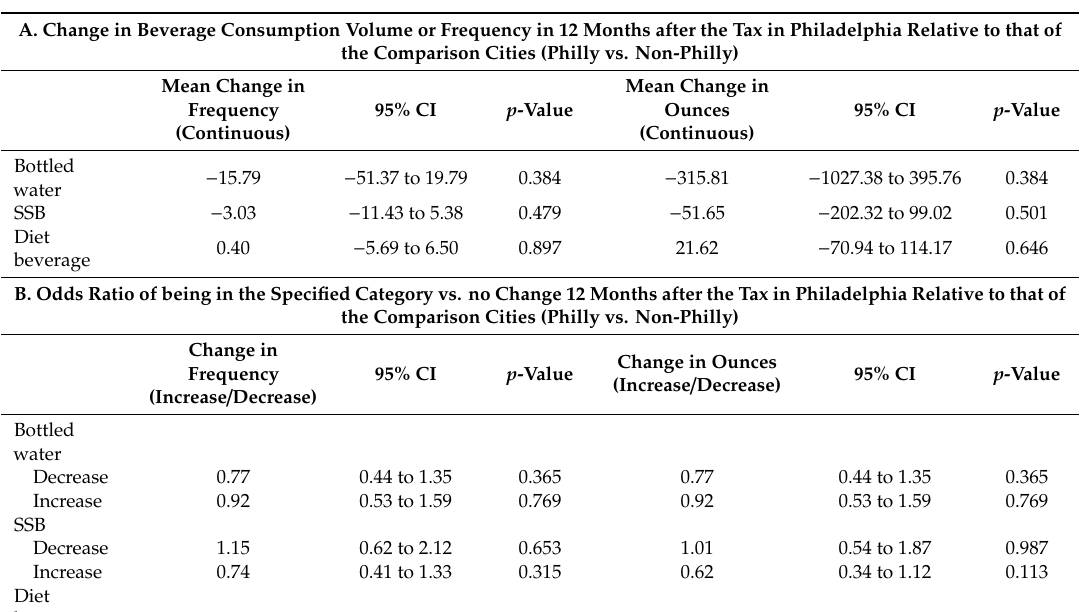
Table 4. Di ff erence-in-di ff erences analysis (adjusted for covariates 1 ), N =